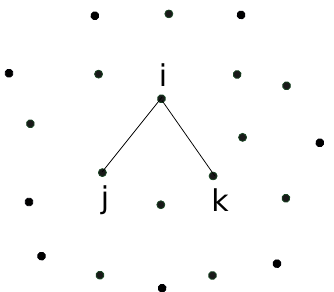
Figure 5 . The local Hamiltonian density de(cid:12)ned at site i in eq. (3.22) includes hoppings between sites j and k which are connected through i via two entanglement bonds. The hopping amplitude is proportional to the product of